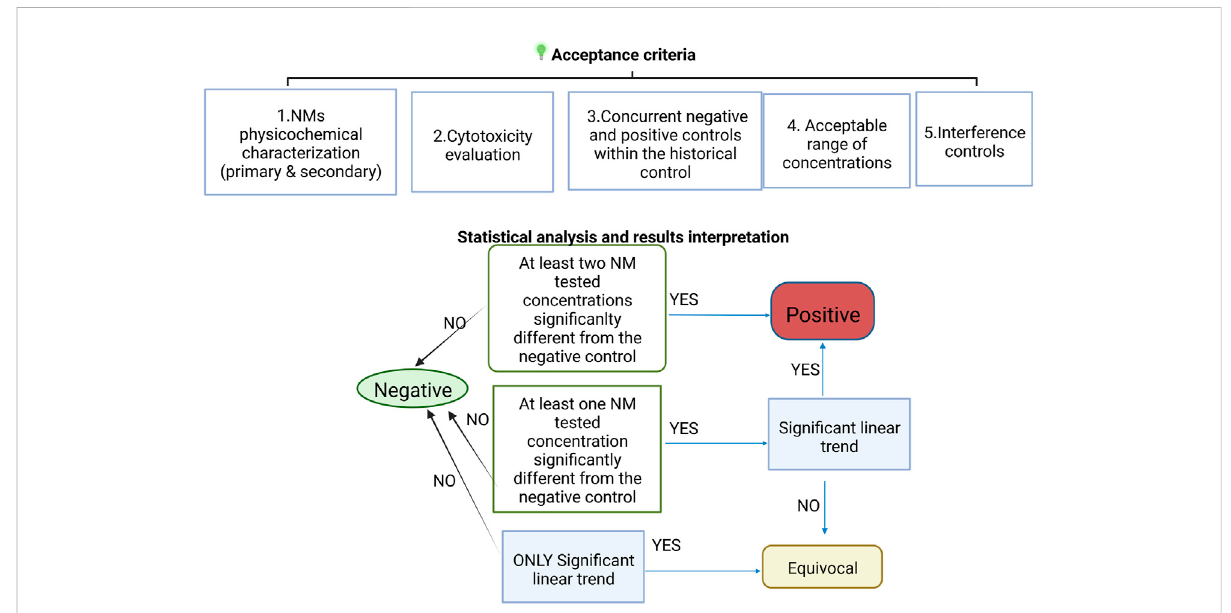
FIGURE 4 Scheme of the test acceptance criteria for NMs testing including the interpretation of the statistical analysis